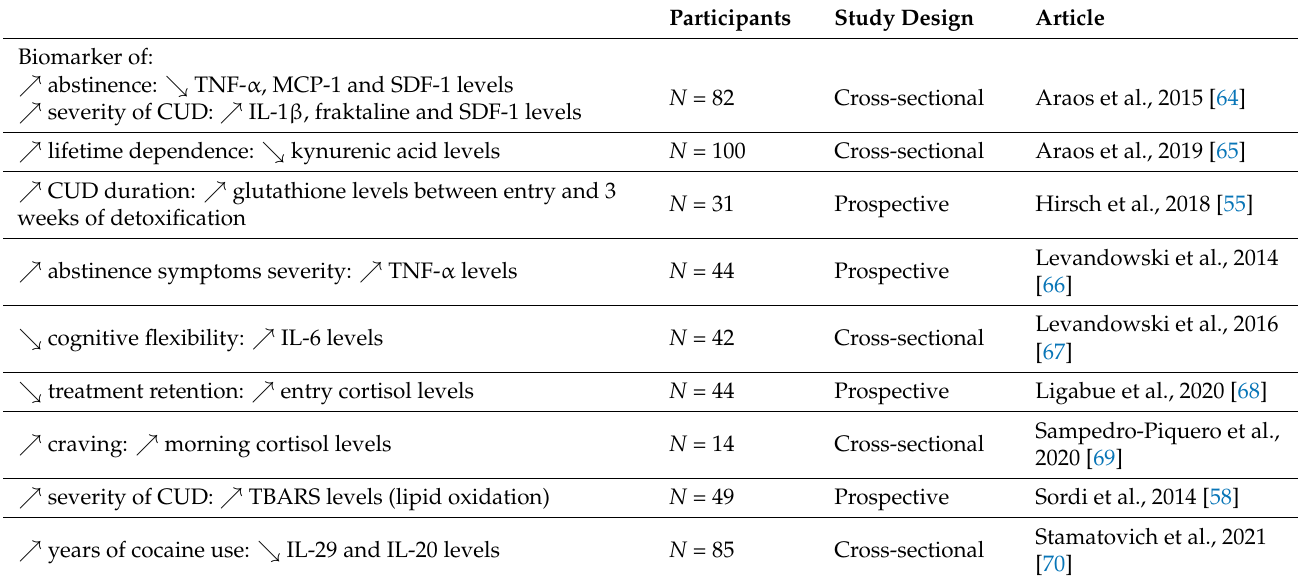
Table 5. Immune system and oxidative stress